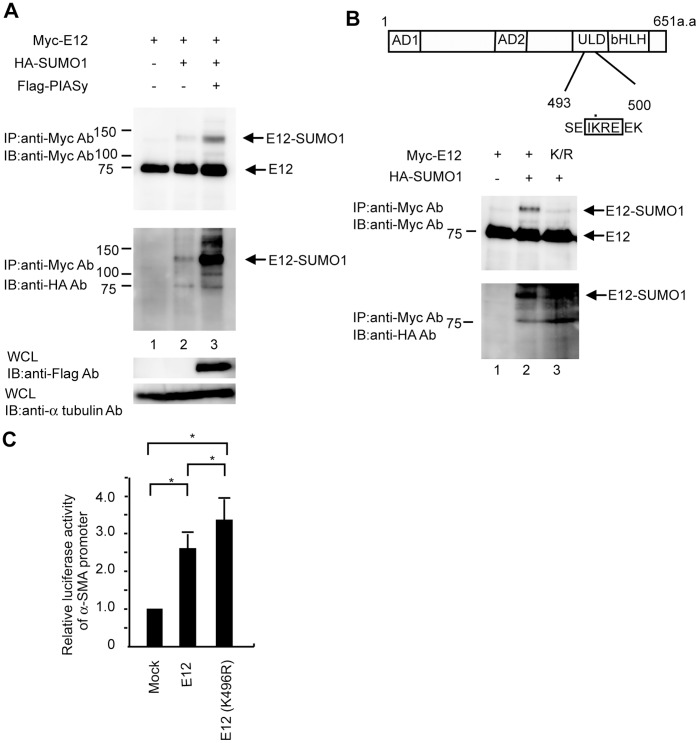
PIASy promotes sumoylation of E12 in vivo.(A) 293T cells were cotransfected with (+) or without (−) 2 µg of plasmid expressing myc-E12, 2 µg of plasmid expressing HA-SUMO-1, and 2 µg of plasmid expressing flag-PIASy. Cell lysates were immunoprecipitated (IP) with anti-myc antibody. The immunoprecipitates were subjected to SDS-PAGE and analyzed by Western blotting (WB) with anti-myc antibody. After ECL development, the filter shown in the first panel was stripped and reproved with anti-HA antibody (second panel). The levels of proteins expressed in whole cell lysates (WCL) were analyzed and shown as indicated. Each experiment was performed at least three times and representative data was shown. (B) SUMO-1 is conjugated at lysine 496 of E12 in vivo. Upper panel, schematic representation of mouse E12. The activation domain I (AD I), activation domain II (AD II) and ubiquitin ligase domain (ULD) are shown. The lysine residue in the putative SUMO-1 acceptor site is indicated by a black dot within the consensus sumoylation sequence. Lower panel, sumoylation of wild-type E12 but not mutant E12 (K/R) in vivo. 293T cells were transfected with plasmids expressing myc-E12 or myc-E12 (K/R) with (+) or without (−) HA-SUMO1. Cell lysates were immunoprecipitated (IP) with anti-myc antibody. The immunoprecipitates were subjected to SDS-PAGE and analyzed by Western blotting(WB) with anti-myc antibody. After ECL development, the filter shown in the first panel was stripped and reproved with anti-HA antibody (second panel). (C) Mouse MCs (0.15×105) were plated in 24-well plates, and six hours later, cotransfected with 25 ng of the wild-type E12 or mutant E12 (K/R) expression plasmid, and 150 ng of the reporter construct. Luciferase activities in lysates prepared 36 hours post-transfection were measured. The activity of the reporter plasmid alone was arbitrary given a value of 1, and the activities of the other transfections were adjusted relative to this assay. Means of three independent experiments in triplicate are shown.